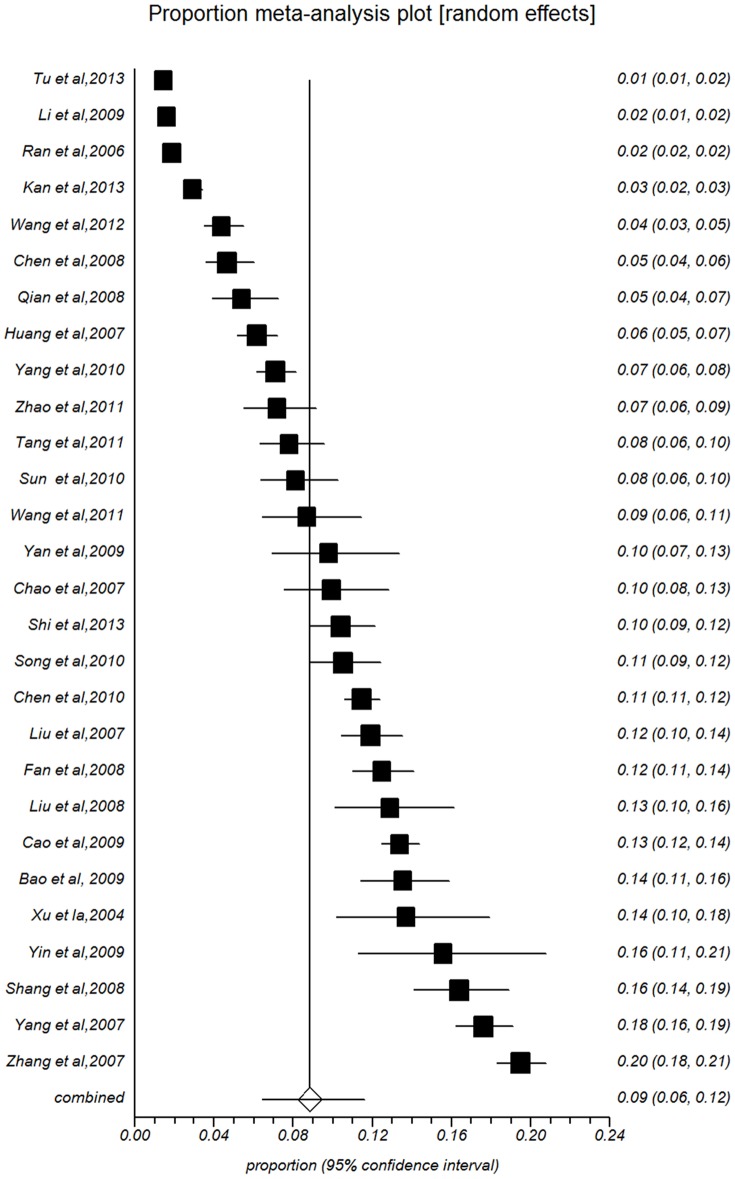
Forest plot of prevalence of suicidal ideation for male.